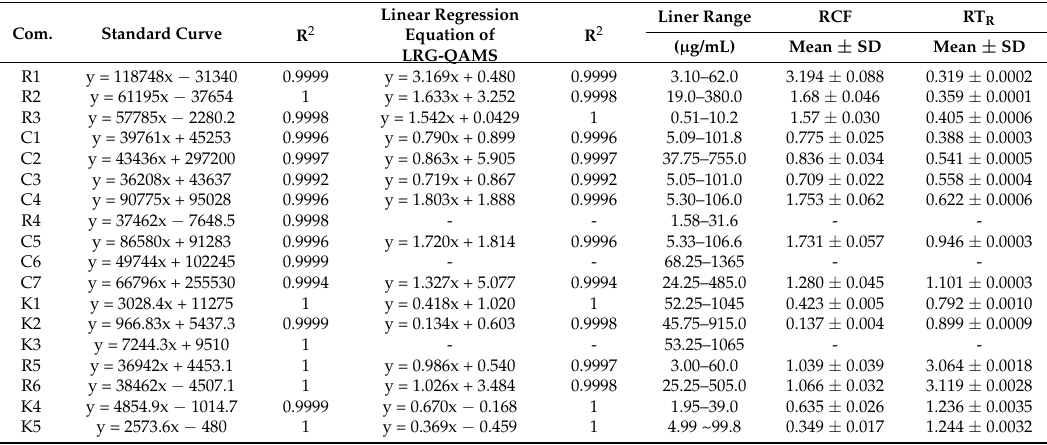
Table 1. The results of linearity, relative conversion factors and relative retention time ( n = 6). Com.